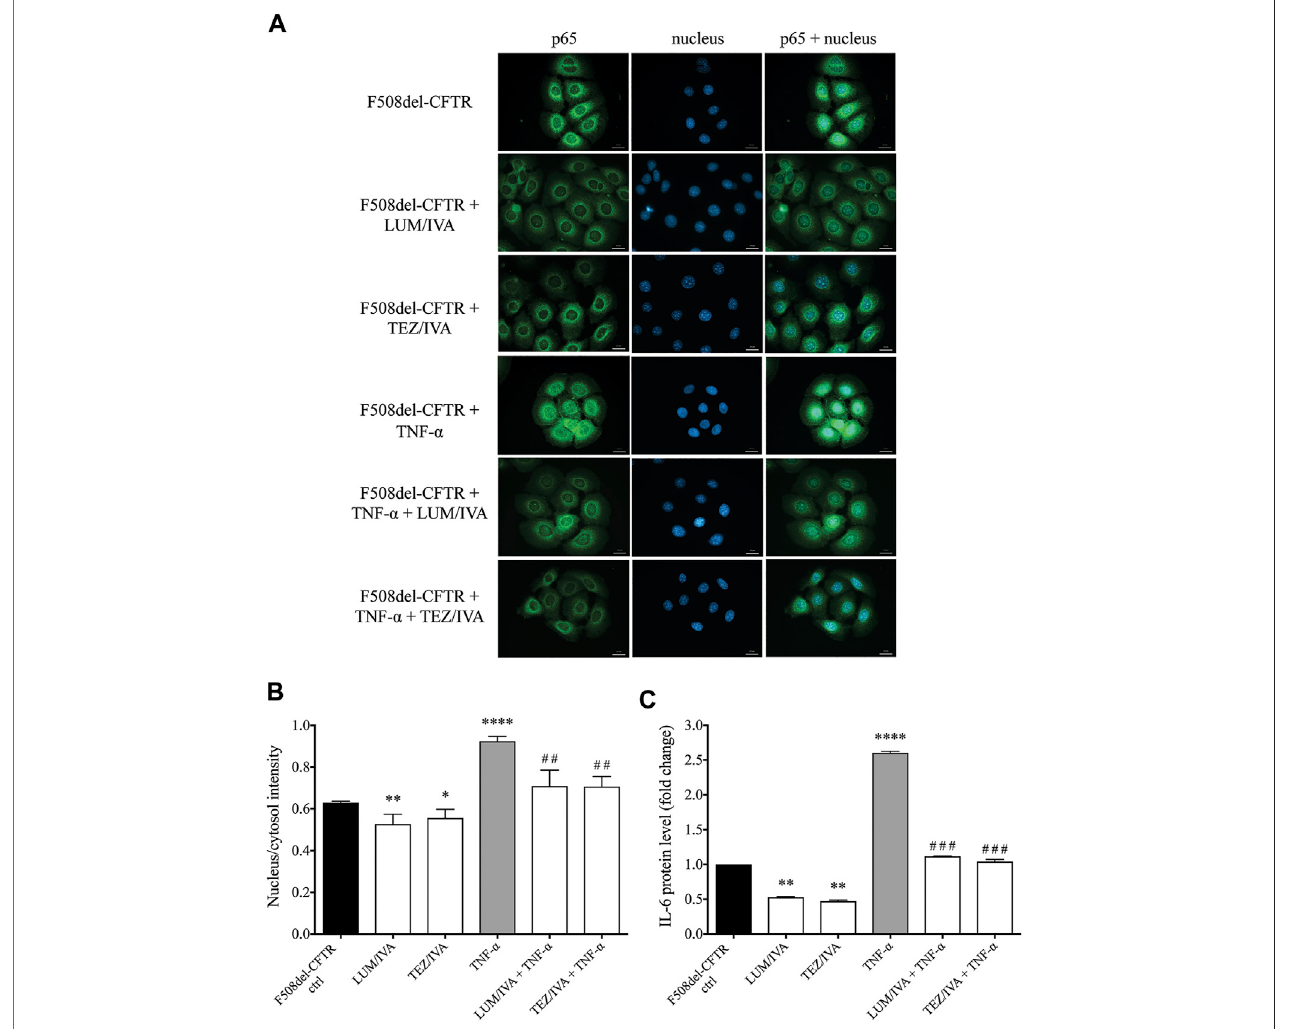
FIGURE 5 | Immuno fl uorescence staining and quanti fi cation of p65 nuclear translocation staining with the analysis of IL-6 protein levels in the presence of CFTR modulators in unstimulated or TNF- α treated CFBE 41o − cells cultures expressing F508del-CFTR. Alteration in p65 nuclear translocation was fi rst analyzed when cells were pretreated with LUM/IVA or TEZ/IVA or DMSO (baseline) for 24 h. CFBE cells were then activated with 100 ng/ml TNF- α or PBS (baseline) for 4 h. Green: p65 staining;blue:cellnuclei.Scalebar:20 μ m (A) FluorescenceintensityoftheNF- κ Bimmunostainingwasanalyzedbasedontheratioofthenucleus/cytosolintensity (B) DownregulatedIL-6proteinlevelsweremeasuredinthesupernatantsofuntreatedandTNF- α stimulatedCFBE410-cellstoapprovetheinhibitionofNF- κ Bpathway activation by CFTR modulators by 24 h (C) Mean ± SEM, n (cid:2) 4 – 5 cells/condition. * p < 0.05, ** p < 0.01, and **** p < 0.0001 vs. control cells with DMSO; ## p < 0.01 and ### p < 0.001 vs. CFBE cells with TNF- α and